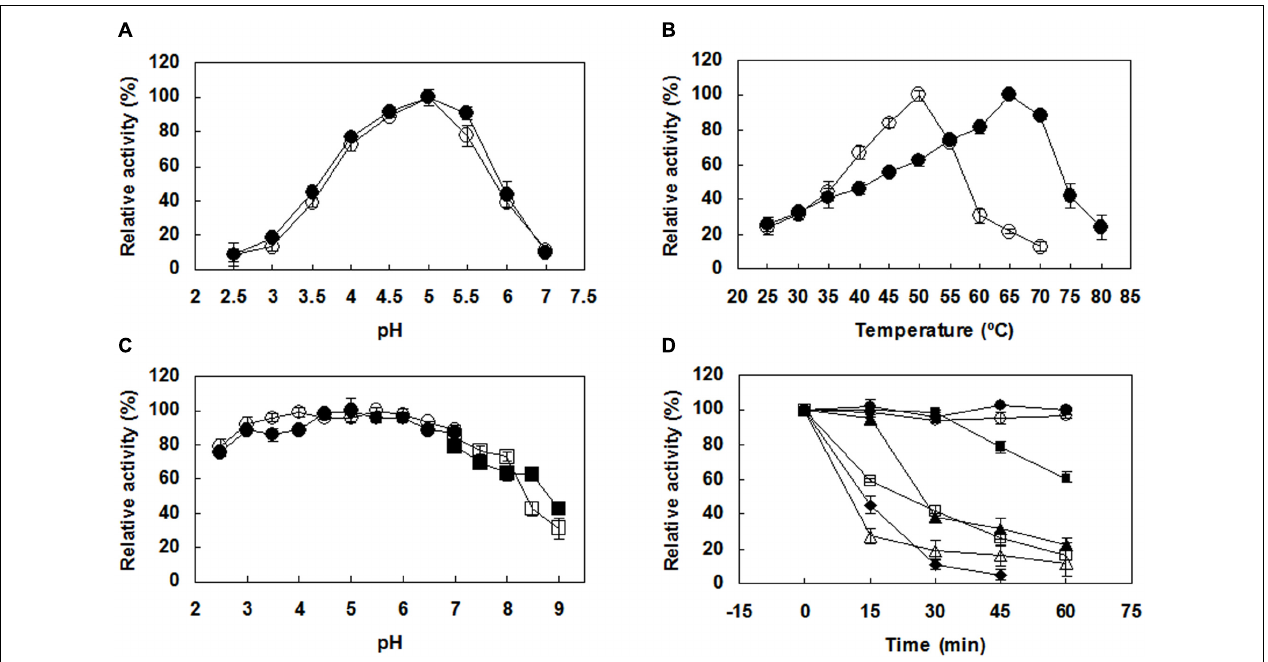
FIGURE 2 | Effects of pH and temperature on the enzyme activity and stability of the purified PoxaEnPG28B-Pp and PoxaEnPG28B-Ec. (A) Effect of pH on enzyme activities of PoxaEnPG28B-Pp ( • ) and PoxaEnPG28B-Ec ( ◦ ). (B) Effect of temperature on enzyme activities of PoxaEnPG28B-Pp ( • ) and PoxaEnPG28B-Ec ( ◦ ). (C) Effect of pH on enzyme stability of PoxaEnPG28B-Pp ( • and (cid:4) ) and PoxaEnPG28B-Ec ( ◦ and (cid:3) ). (D) Effect of temperature on enzyme stability. For PoxaEnPG28B-Pp, temperatures were 50 ◦ C ( • ), 55 ◦ C ( (cid:4) ), 60 ◦ C ( (cid:78) ), and 65 ◦ C ( (cid:7) ), respectively. For PoxaEnPG28B-Ec, temperatures were 35 ◦ C ( ◦ ), 40 ◦ C ( (cid:3) ), and 45 ◦ C ( (cid:52) ), respectively. Error bars present the standard deviation of three repeats.